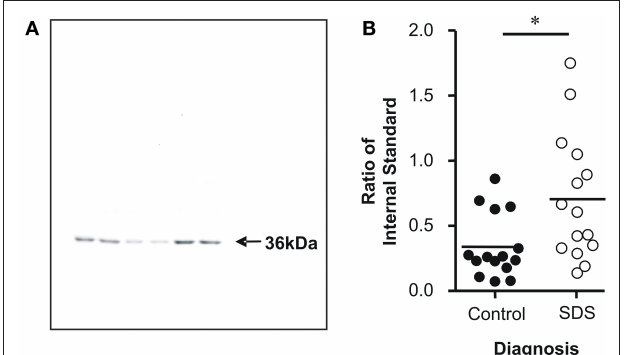
FIGuRE 1 | Western analysis of APOE protein expression in subjects with short duration of illness schizophrenia (SDS) was performed on a 36-kDa immunogenic band, which corresponded to the predicted size of APOE (A). The level of APOE protein expression was increased Brodmann’s area 46 from subjects with SDS compared to controls (B) . Values are expressed as ratios of APOE expression in an independent BA9 protein extract (internal standard) * P <